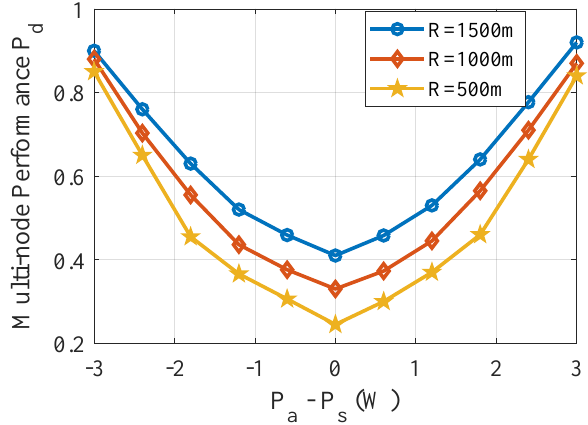
Figure 5. Performance of TPV detection with multiple nodes, which demonstrates that the “L out of K" can improve the performance by